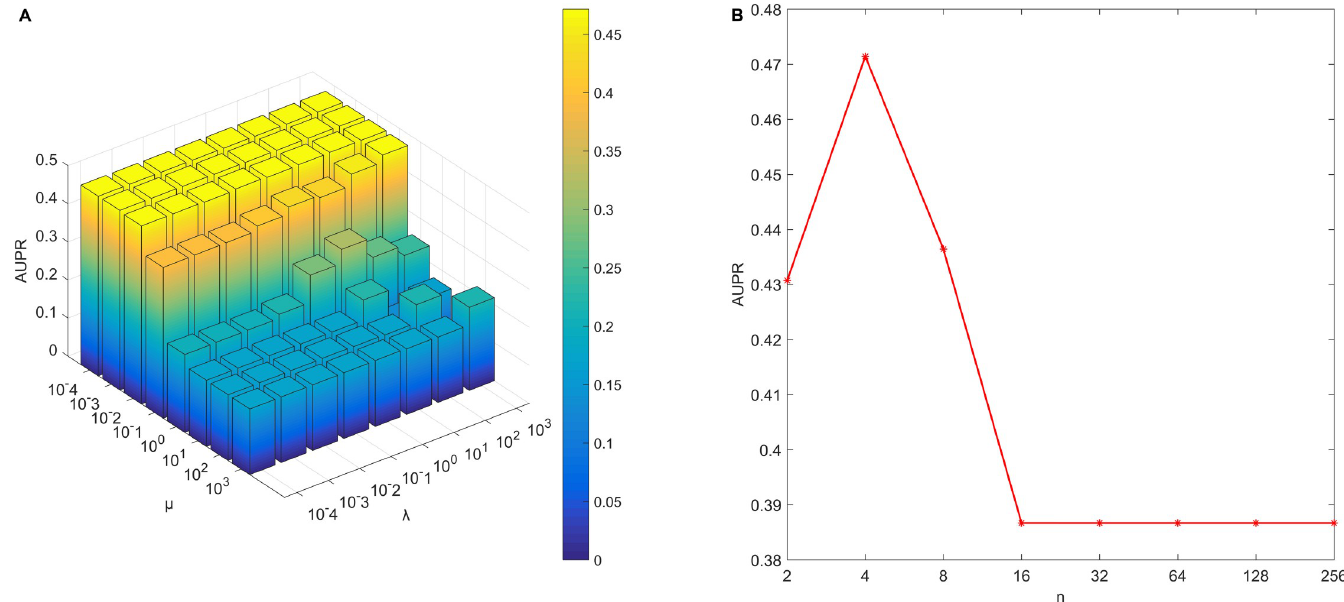
Fig 2. The influence of parameters on AUPR of models. (A) Fix the parameter η = 2 2 , and evaluate the influence of parameters μ and λ . (B) Fix the parameter μ = 10 − 1 , λ = 10 3 , and evaluate the influence of parameter η